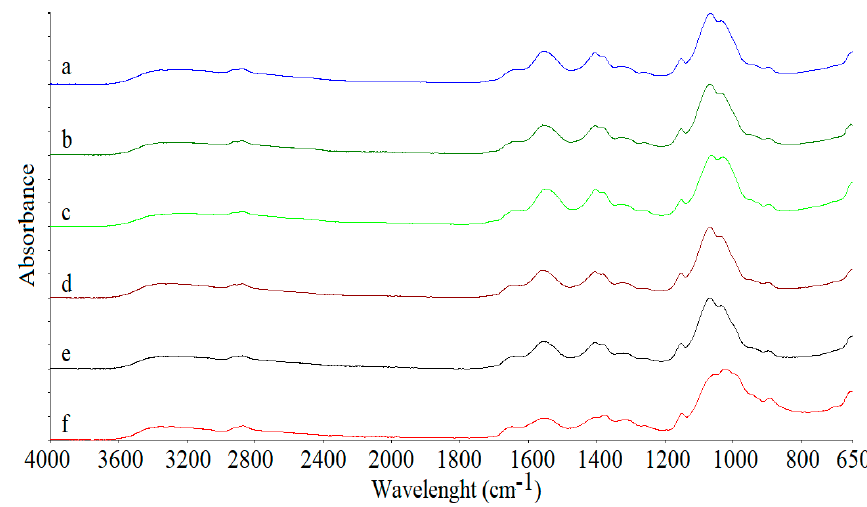
Figure 2. Fourier-transformed infrared spectra of freeze-dried chitosan solutions prepared with 1.0 ( a ), 0.8 ( b ), 0.6 ( c ), 0.4 ( d ), 0.2 ( e ), and 0.0% ( f ) of acetic acid solutions.